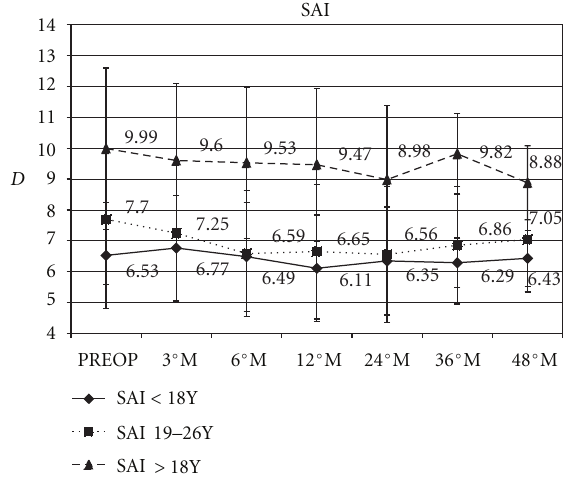
Figure 6: Graph showing the COMA analysis and the improving value in paediatric patients by a mean of − 0.47 µ m, − 0.52 µ m, − 0.47 µ m, and − 0.45 µ m; in the intermediate group coma values decreased by a mean of − 0.89 µ m, − 0.96 µ m, − 0.93 µ m, and − 0.91 µ m; in old patients we recorded a mean postoperative value of − 0.2 µ m, − 0.18 µ m, − 0.21 µ m, and − 0.19 µ m at 12, 24, 36, and 48 months of followup,